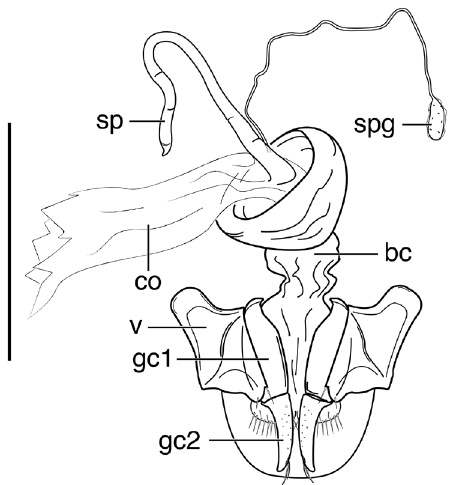
Figure 16. Line drawing of female reproductive tract of Selenophorus discopunctatus species group, in part, S. yucatanus Putzeys, ventral aspect. Legend: bc bursa copulatrix; co common oviduct gc1 gono- coxite 1 gc2 gonocoxite 2 sp spermatheca spg spermathecal gland v valvifer. Scale bar 1